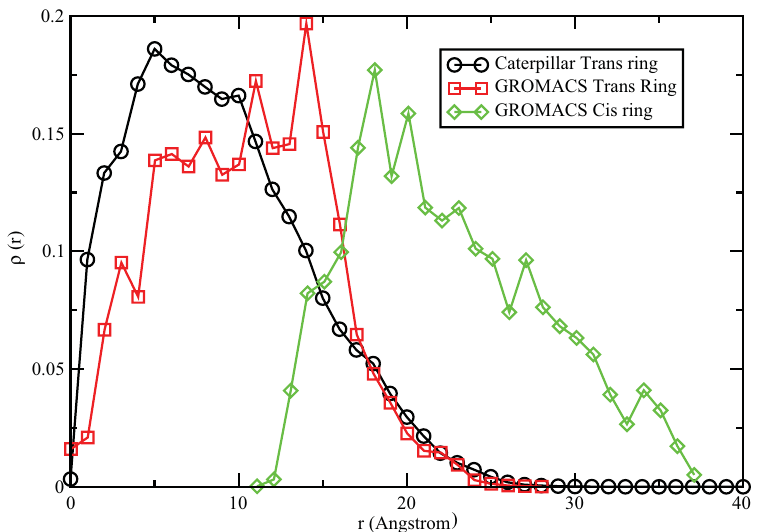
Figure 4. Plot of the density profile r [ r ] of the filament’s C a as a function of the radial distance from the central axis of the hole r . The data are obtained with the caterpillar model of the chains in the trans ring (circles), and with GROMACS full atomistic simulations for the trans (squares) and cis (diamonds) chains. The remarkable overlap between the distributions indicates that we do reproduce the static picture of a blocked hole. The density distribution generated by the coarse-grained model is more peaked than the one generated in the atomistic simulations. This indicates that, if anything, the coarse-grained model will overestimate the extent to which the disordered peptide chains hinder translocation. The coarse-grained model predicts that the chains in the cis region are far from the center of the hole and do not impede the passage of an a